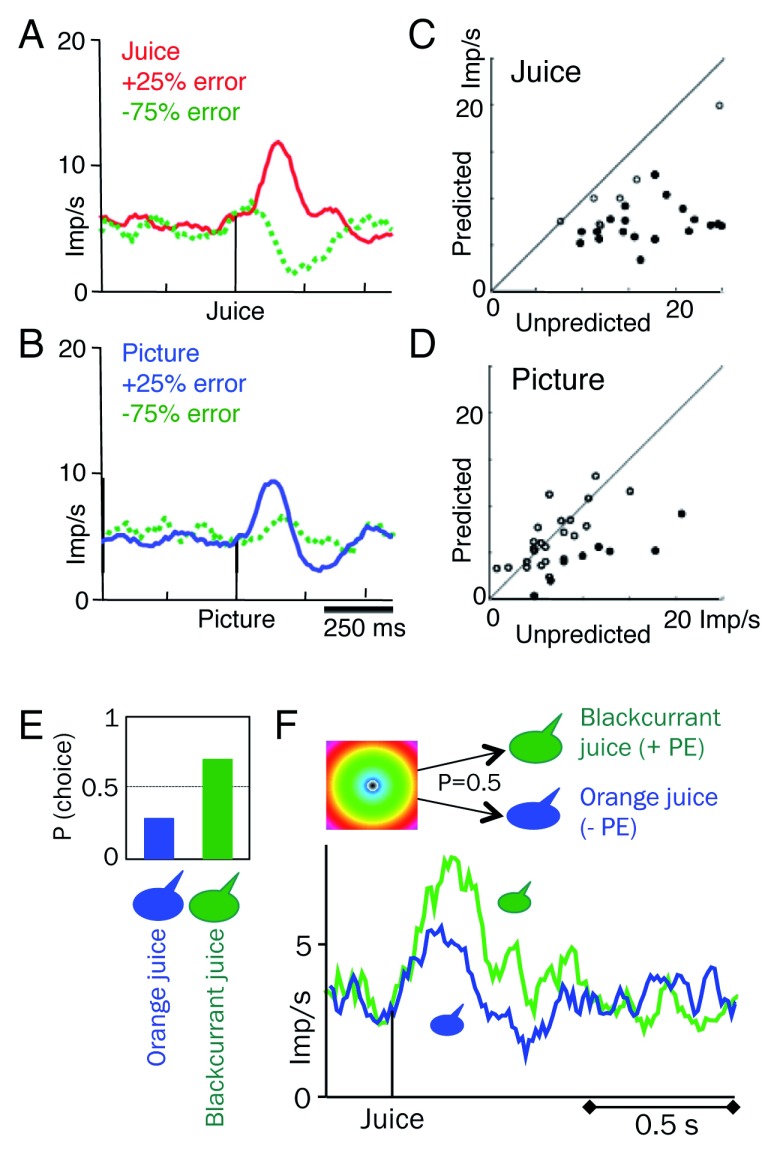
Surprise salience coding with non-rewarding stimuli contrasts with reward prediction error coding(
A) Bidirectional prediction error coding for juice reward. The animal received juice reward in 75% of trials but not in 25% of trials. Hence, a reward that did occur generated a 25% positive prediction error, and an omitted reward generated a 75% negative prediction error. (
B) With similar 75 to 25% presentation of non-rewarding arbitrary (fractal) picture, unidirectional response enhancement with surprising picture occurrence (+25% picture prediction error), without negative error coding with picture omission (−75% picture error). (
C) Reward response increase with unpredicted reward delivery (compatible with positive reward prediction error coding). Closed circles indicate significant differences (
P <0.05;
t test). (
D) Smaller response enhancement with unpredicted picture occurrence, reflecting surprise salience.
A–
D are reused from Kobayashi and Schultz
38 Figure 4 (A, B, E, F),
CC BY 3.0. (
E) Preference for blackcurrant over orange juice in binary, simultaneous choice (same liquid amounts), indicating higher value of blackcurrant than orange juice
18. (
F) Dopamine prediction error response for juice identity reflects reward value. The concentric stimulus predicts equiprobable delivery of either blackcurrant or orange juice; the neuronal response reflects the prediction error between the value of the received juice and the stimulus-predicted mean value of the two juices (green: positive; blue: negative, with initial-component activation)
18.